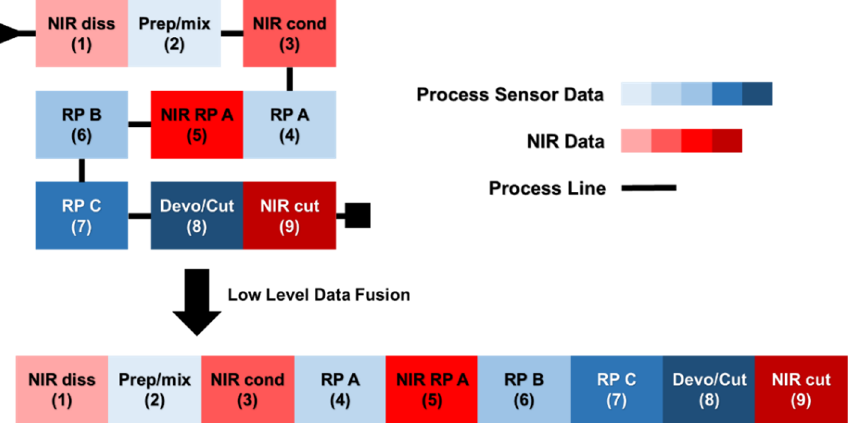
Figure 1. Schematic representation of the low-level data fusion approach resorted to in this study. Values in brackets indicate the chronological order of the data blocks. Values in brackets indicate the chronological order of the data